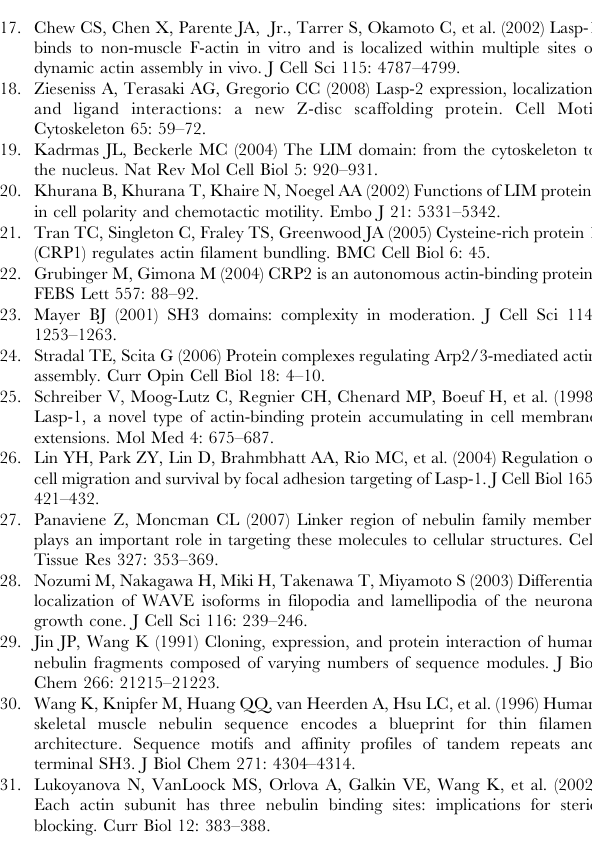
Figure S1 A schematic representation of the domain structure, F-actin-binding activity, and subcellular localization of avian lasp- 2 D e1 fragments. (A) LIM and SH3 indicate the LIM and Src homology 3 domains, respectively. The number of nebulin repeats is shown by n1 to n3. The D e1 fragment has a defective coding region of exon1 of avian lasp-2 as shown by the double-headed arrow above lasp-2. (B) 0.2 mg/ml G-actin was polymerized with GST- D e1 ( D e1). Since the expression level of D e1 in bacteria was low and the purified protein was aggregated easily, we performed a co-precipitation assay of D e1 at a molar ratio of 1/10. GST- D e1 (arrowhead in A) was not co-precipitated with actin filament. FA indicates a control experiment using F-actin without the recombinant peptides. The precipitants (p) were separated from the supernatant (s) by ultracentrifugation as described in Materials and Methods. The mobilities of molecular mass markers are listed on the right of the gel images in kilodaltons. (C) Fluorescence image of NG108-15 cells transfected with EGFP- D e1. The bar represents 10 m m. Found at: doi:10.1371/journal.pone.0007530.s002 (0.11 MB